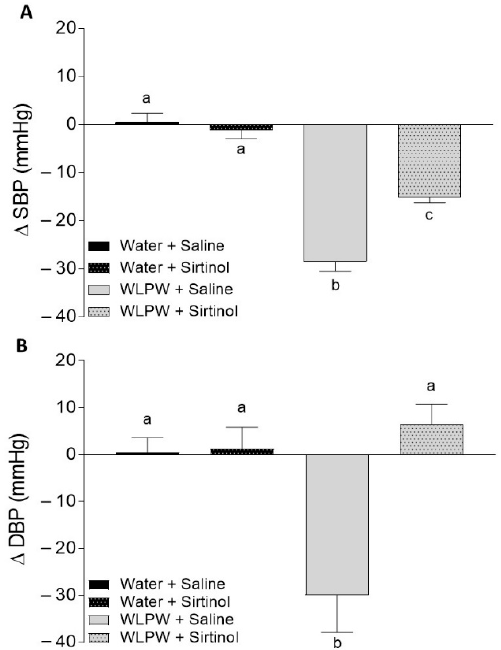
Figure 4. Changes in systolic blood pressure (SBP) ( A ) and diastolic blood pressure (DBP) ( B ) caused in spontaneously hypertensive rats 6 h post-administration by different treatments: oral administration of water or wine lees powder (WLPW) and intraperitoneal injection of Saline or Sirtinol. Significant differences ( p < 0.05) are represented by different letters and p was estimated by one-way ANOVA.